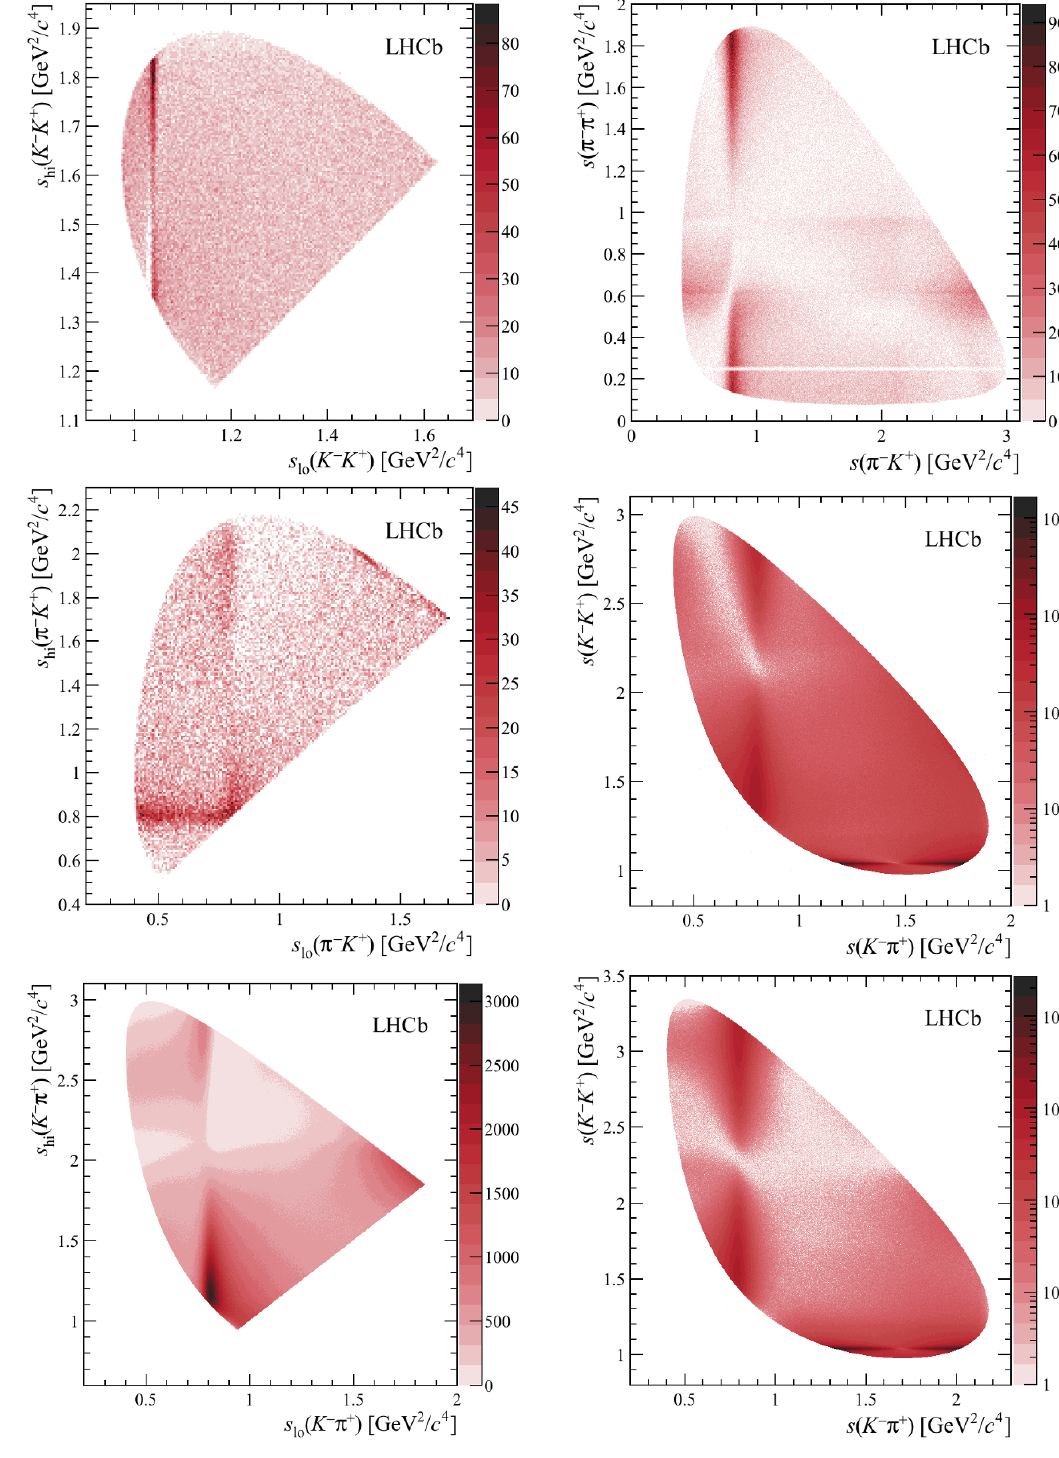
Figure 5 . Dalitz plots of the (top left) D + ! K (cid:0) K + K + , (top right) D + ! (cid:25) (cid:0) (cid:25) + K + , where the K 0 veto can be seen, (middle left) D + S D + ! K (cid:0) (cid:25) + (cid:25) + and (bottom right) D + logarithmic scale is used for the D + ! K (cid:0) K + (cid:25) + and D +